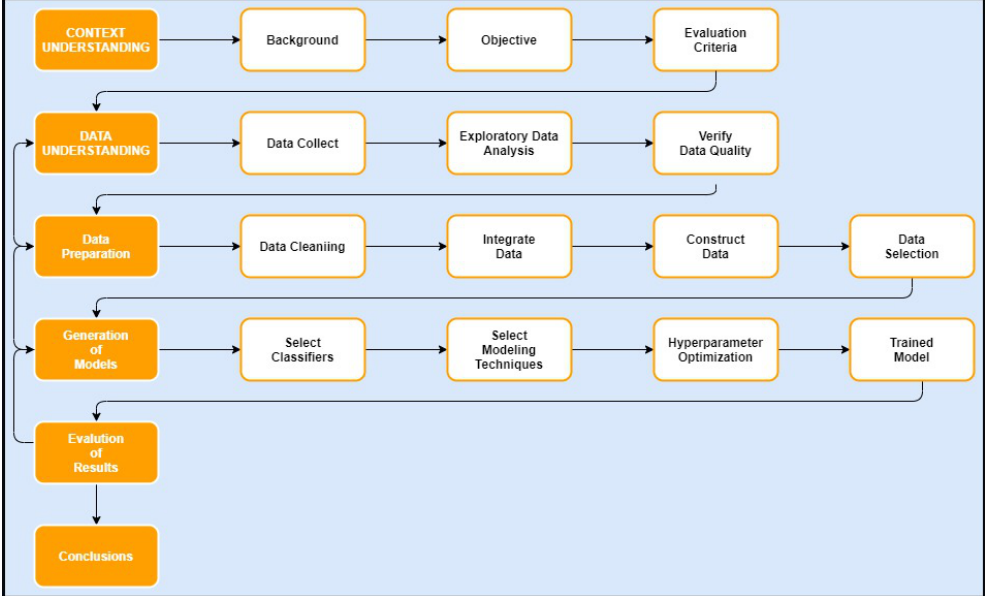
Figure 1. Modelo